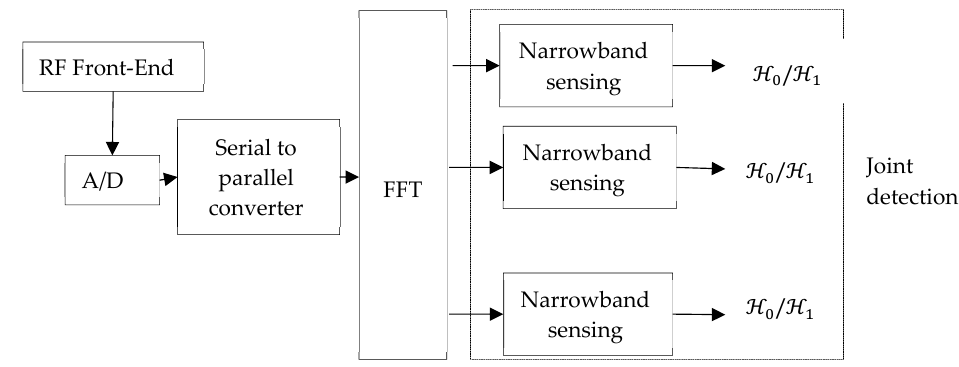
Figure 7. Block diagram of multiband joint detection [77,78].